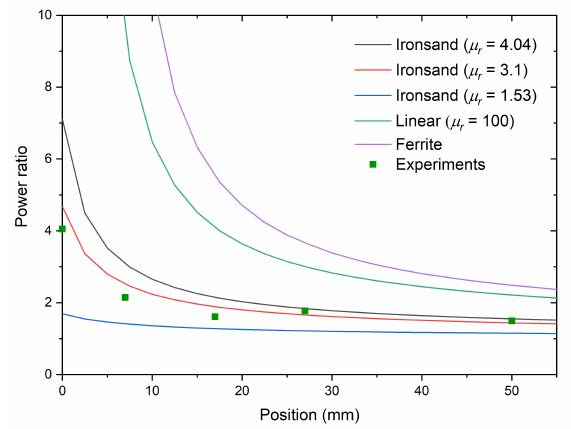
Figure 8. Evolution of the apparent power with/without ironsand at different distances to the pick- up for different relative magnetic permeabilities. The “Linear” dataset corresponds to a hypothetical material that will stay at a constant permeability of 100 over the range of magnetic fields in these conditions. The Ferrite dataset corresponds to the simulation with a slab of the same ferrite and the same thickness as the U-shaped core. The scatter plot represents the experimental